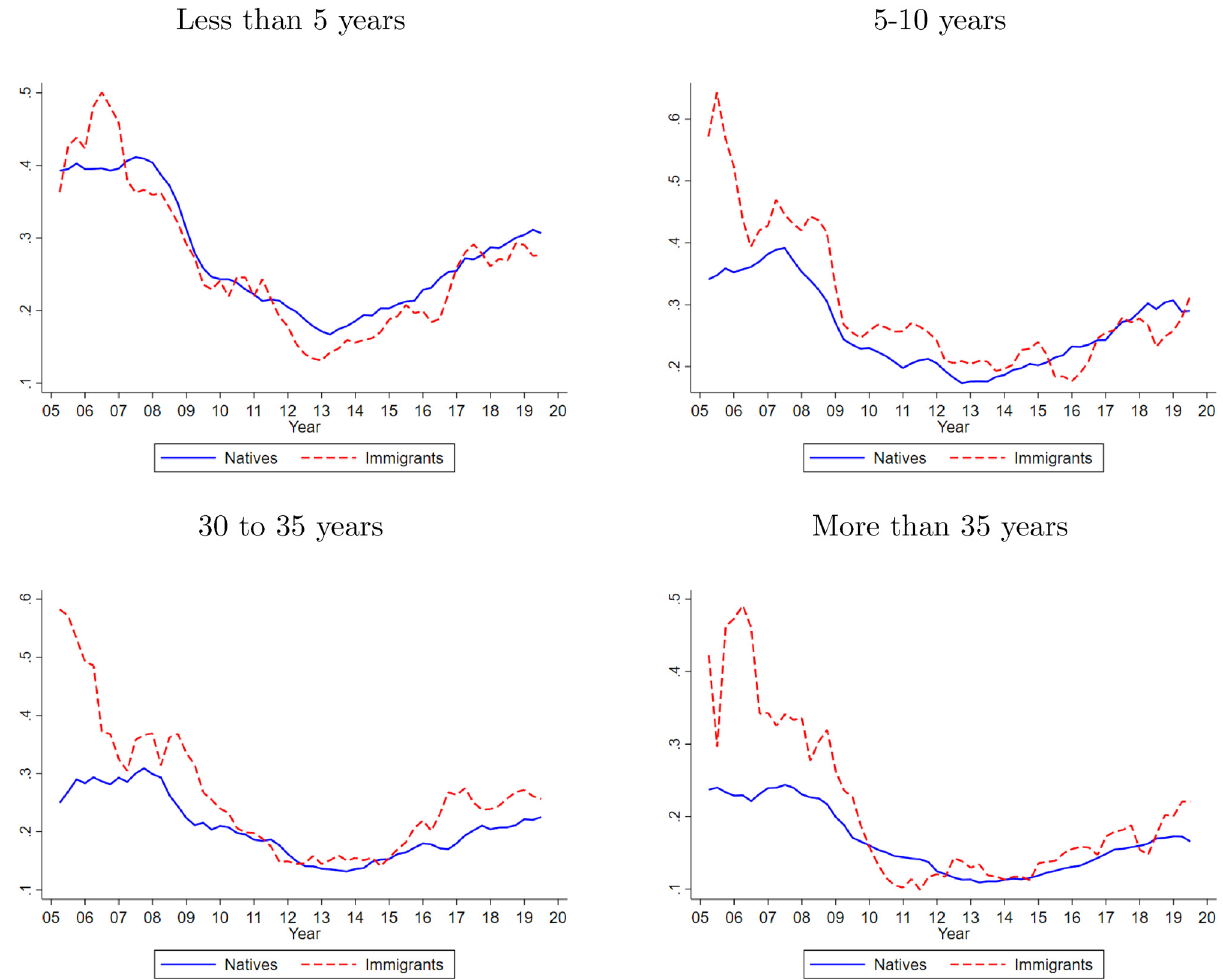
Figure A3: Job - fi nding rate by nationality and experience. Note: The transitions are seasonally adjusted using a 4 - quarters moving average, constructed from the Spanish Labour Force Survey -